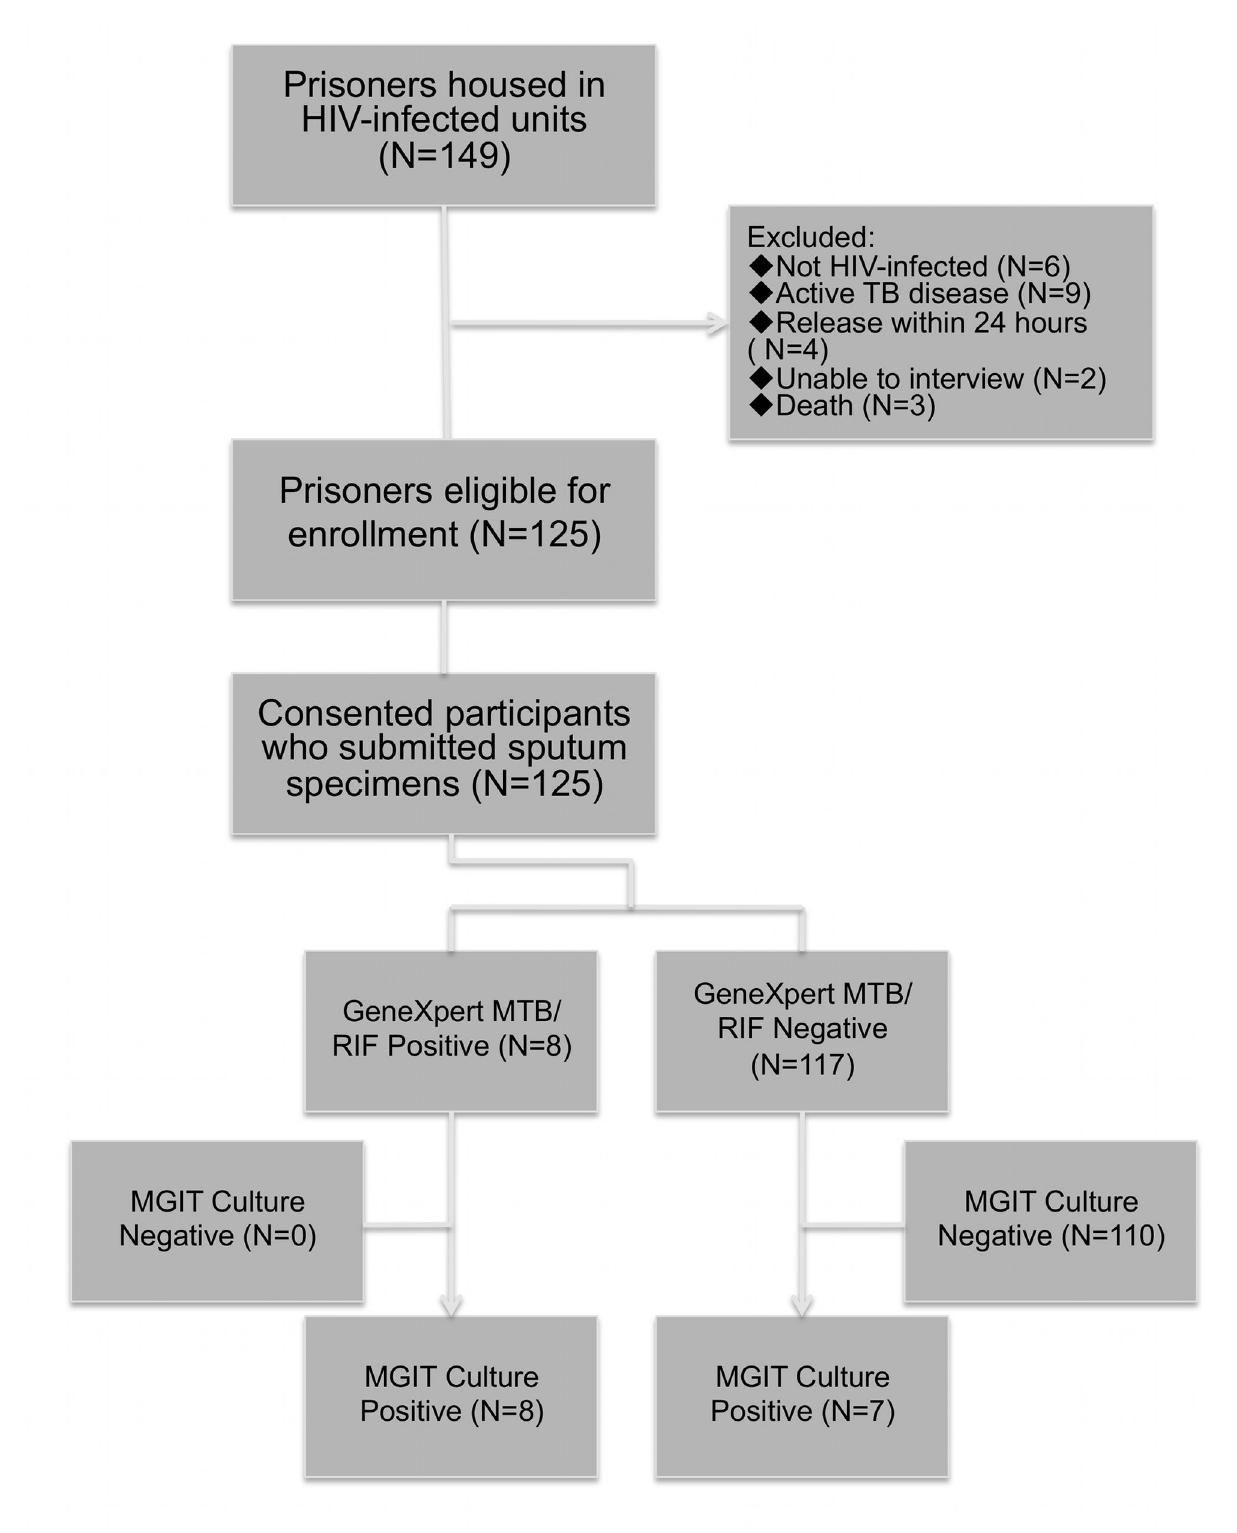
Figure 1. The recruitment and findings flowchart.